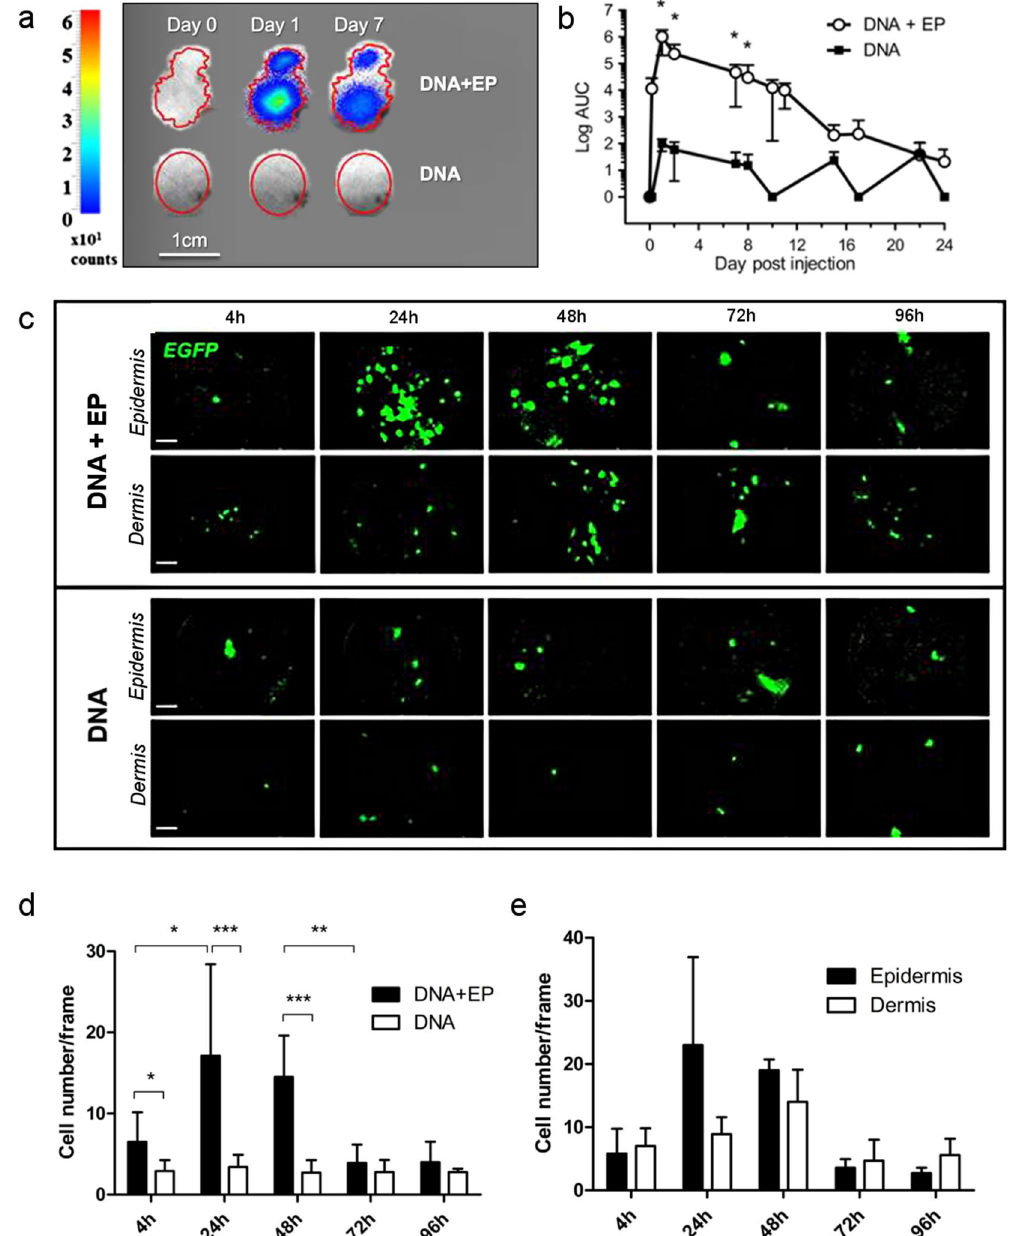
Figure 1. In vivo imaging of vaccine antigen expression at the site of injection. ( a ) Representative in vivo bioluminescent images of luciferase expression in macaque skin at day 0, 1 and 7 after intradermal injection of auxoGTU ® -luc-EGFP ± EP. ( b ) Quantification of luciferase expression after vaccination with (n = 10) or without electroporation (n = 3). Mann-Whitney test. ( c ) In vivo fibered confocal microscopy showing EGFP expression by auxoGTU ® in the epidermis and the dermis after vaccination ± EP. Scale bar: 100 µ m. ( d ) Quantification of EGFP + cells from 4 to 96 h after vaccination, from 10 different frames. Paired and unpaired t-test. ( e ) Distribution of EGFP + cells in the epidermis and the dermis after DNA vaccination with electroporation. Data are presented as mean ± SD; * p < 0.05; ** p < 0.01; *** p < 0.001; EP,